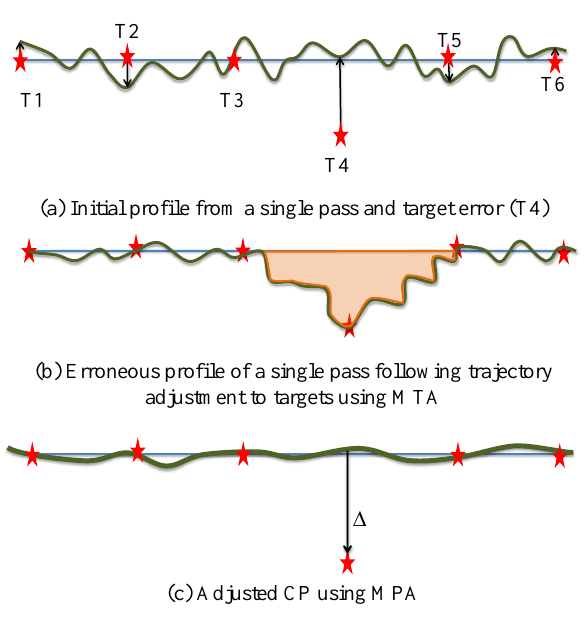
Figure 3 – Example schematic of pinning trajectory to an incorrect control point (T4). The blue line represents the “true” CP, the green line represents the processed CP with associated errors, the orange area highlights the area affected by these errors, and the stars represent locations of targets.